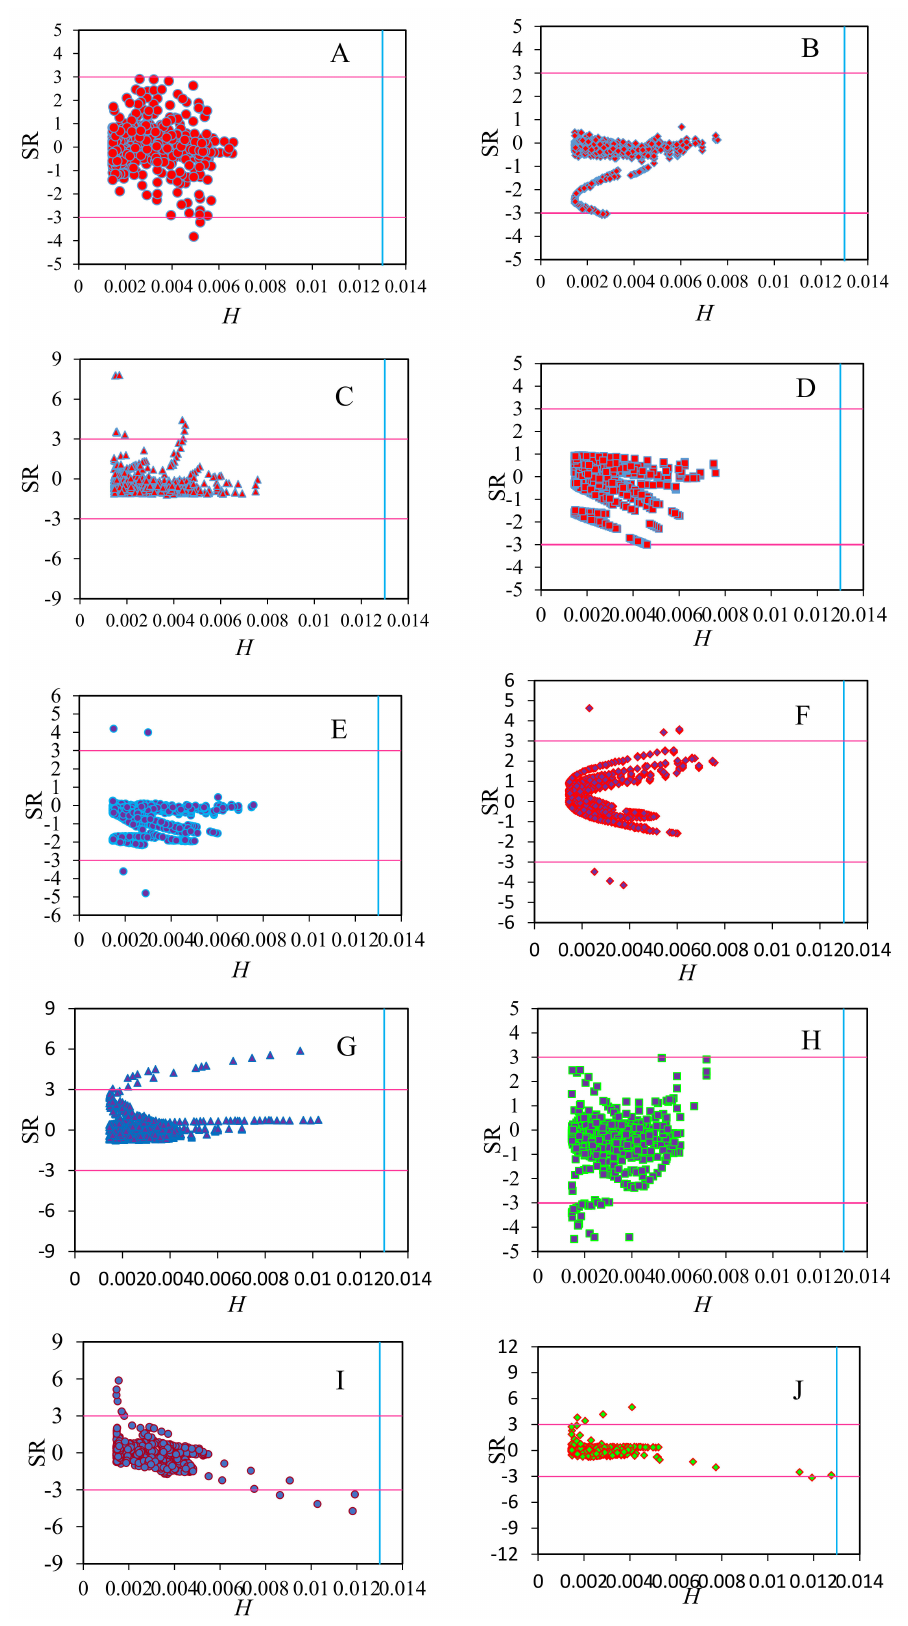
Figure 5. Outlier detection results for each model (( A ): GA-SVM model. ( B ): Amin model. ( C ): Berger model. ( D ): Hammerschmidt model. ( E ): Towler model. ( F ): Motiee model. ( G ): Kobayashi model. ( H ): Ghayyem model. ( I ): Zahedi (3) model. ( J ): Zahedi (4)